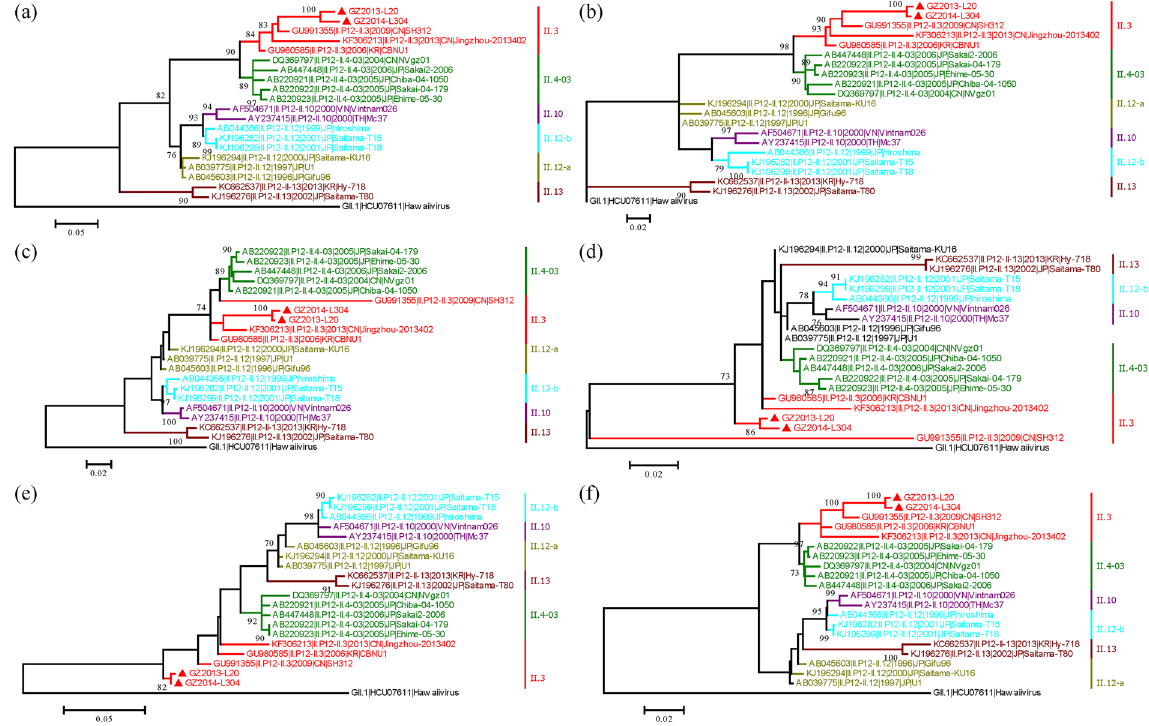
Figure 2. Phylogenetic trees of ORF1-GII.P12 recombinants based on nucleotide sequences of different protein encoding regions in ORF1: ( a ) p48, ( b ) NTPase, ( c ) p22, ( d ) VPg, ( e ) 3C-Pro, and ( f ) RdRp. Maximum likelihood trees were constructed using PhyML 3.0 with the general time-reversible (GTR) substitution models by jmodeltest 2 program. Numbers at the nodes indicate supporting bootstrap values (%) for 1000 resampled datasets, and only values greater than 70% are shown. The scale bar represents the unit for the expected number of substitutions per site. Guangzhou NoV strains are designated by location, year, and identification number (indicated by the black diamond). Reference sequences are indicated by their accession numbers, genotypes, years, countries, and strain names. The reference strain GII.1|HCU07611|Hawaii virus was selected as the root of phylogenetic